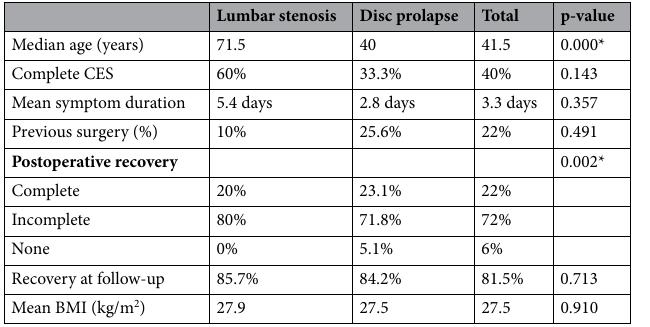
Table 1. Characteristics of patients suffering from cauda equina syndrome (CES), subgrouped by underlying cause of CES showing significant differences (*) in age and direct postoperative recovery.